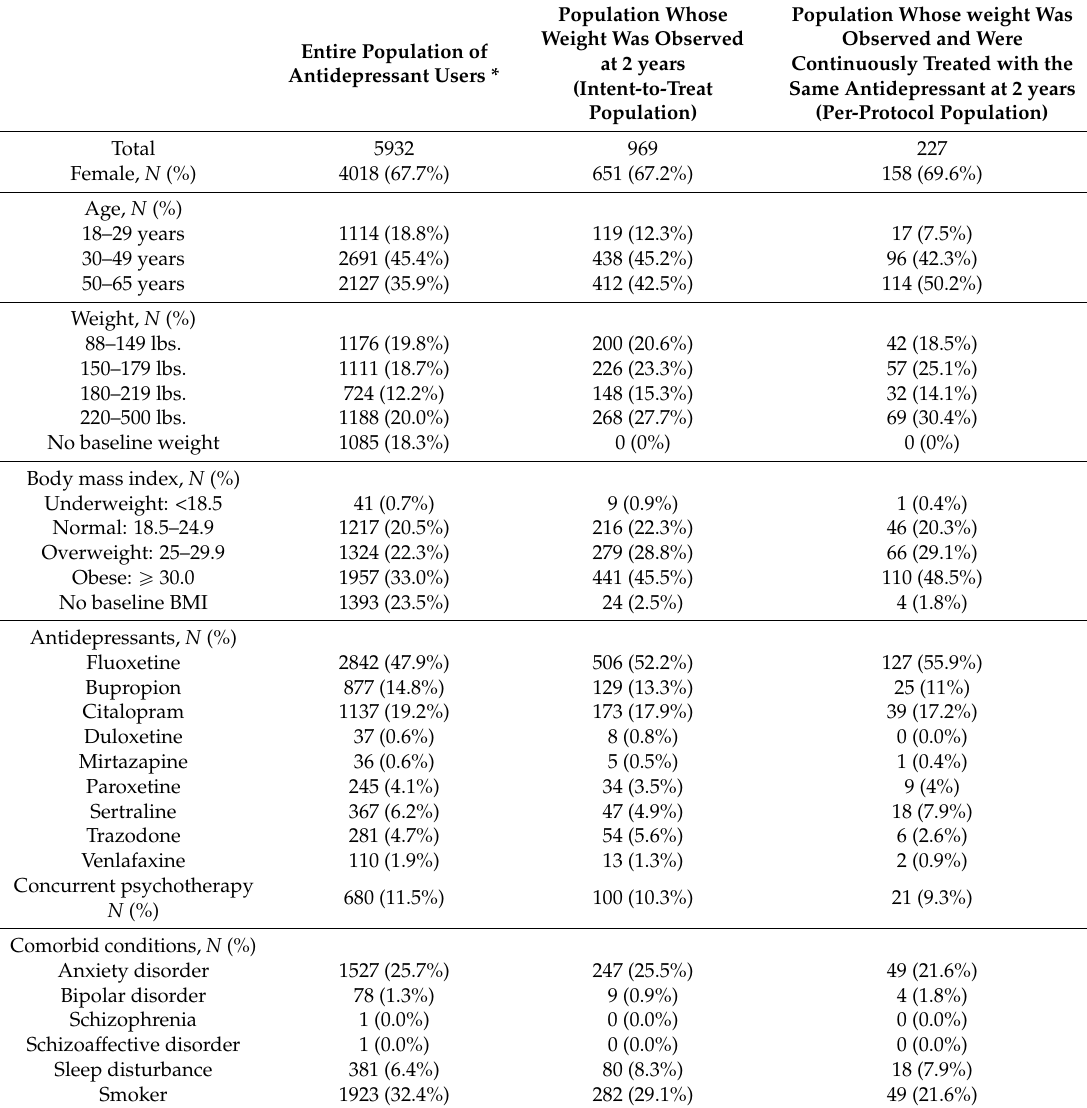
Table 1. Characteristics of the entire population of antidepressant users and antidepressant users with observable weight data at two years